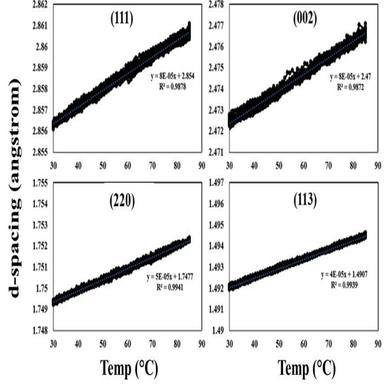
Fitted peak position vs. temperature for the Pb (111), (002), (220), and (113) reflections after one thermal cycle.